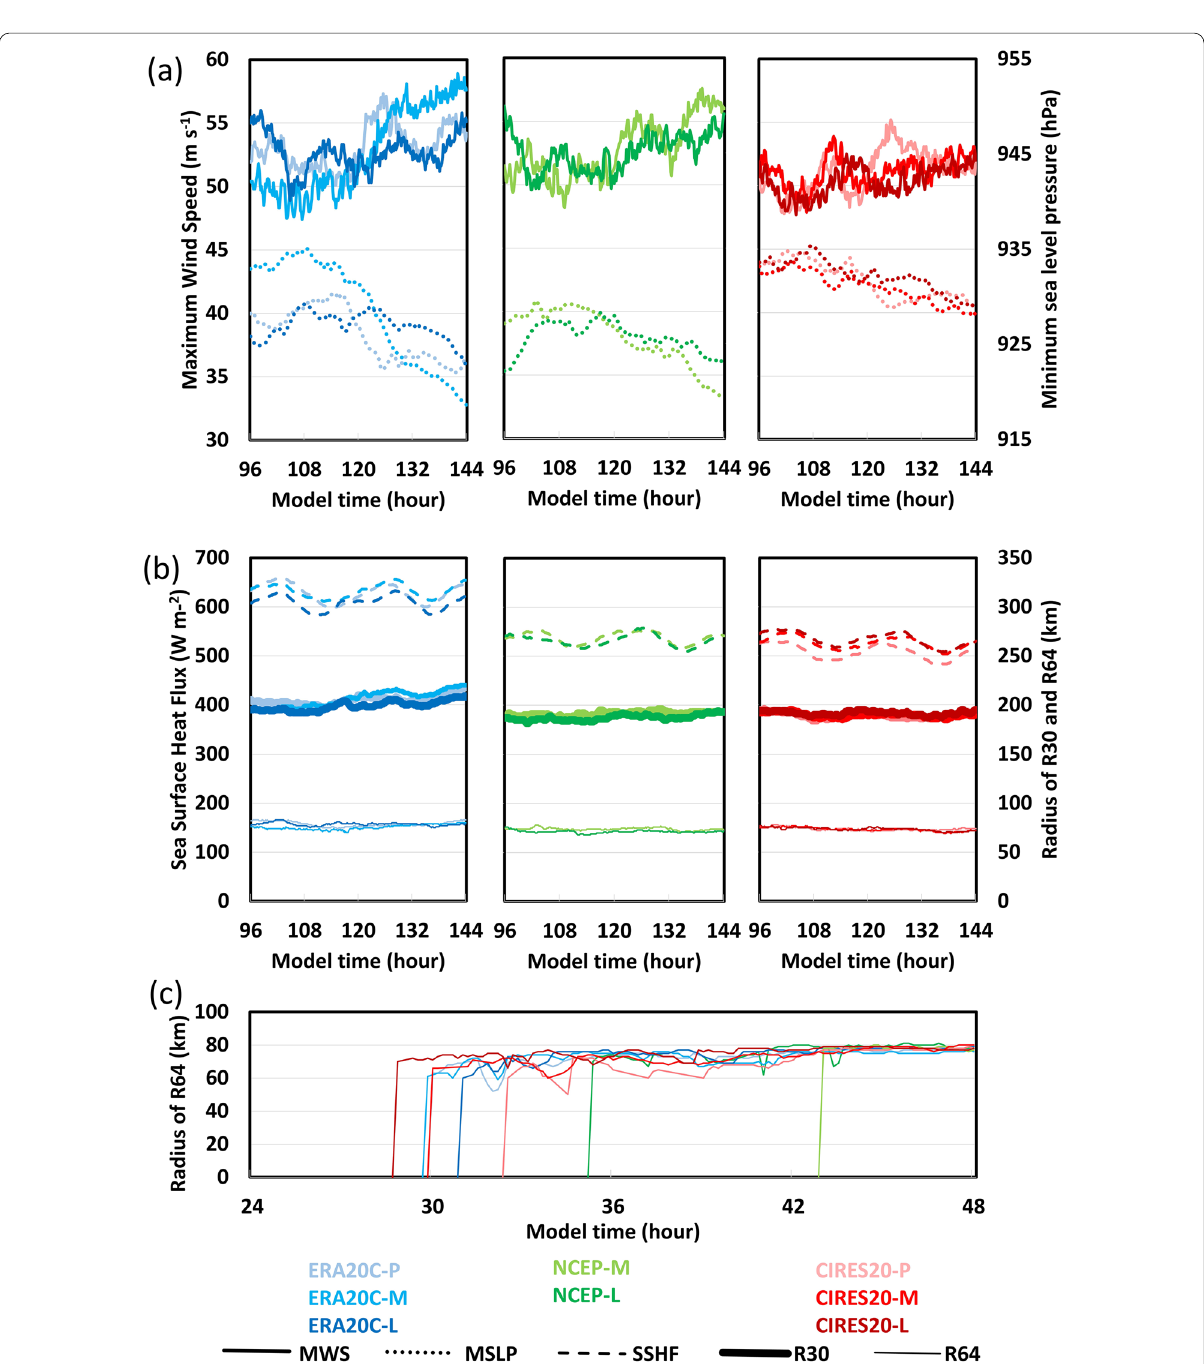
Fig. 8 Same as in Fig. 4, but is distinguished from three reanalysis experiments and for a MSLP (dotted lines) and MWS (solid lines); b SSHF (long dashed lines), R30 (thick lines), and R64 (thin lines) from 96 to 144 h; c R64 in earlier period of reanalysis sensitivity